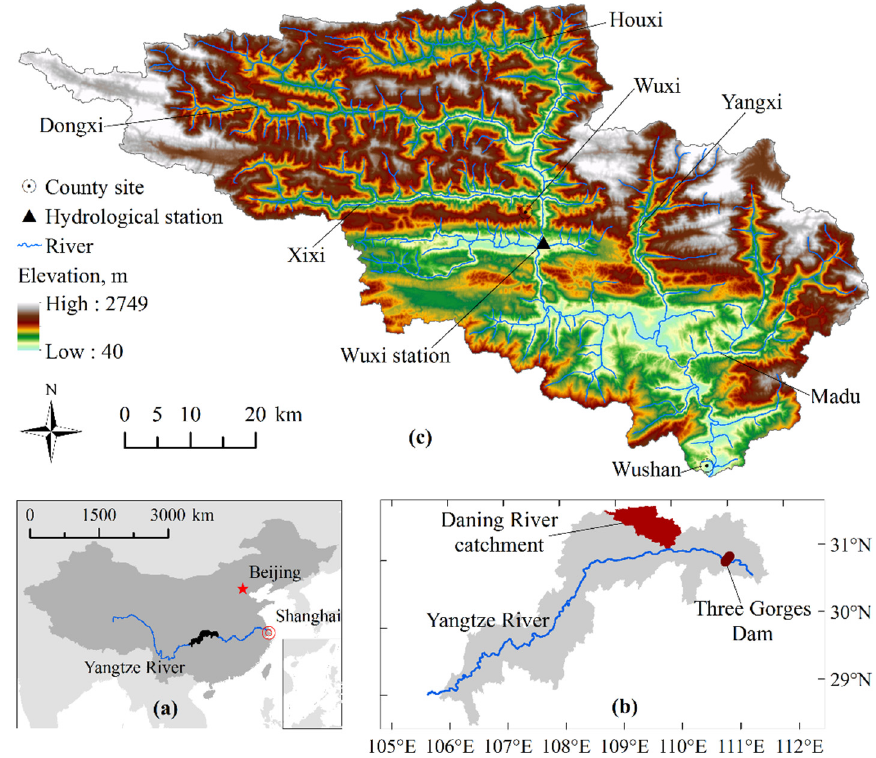
Figure 1. Location of the Daning River catchment: ( a ) map of China; ( b ) Three Gorges Reservoir Region; and ( c ) Daning River Catchment.